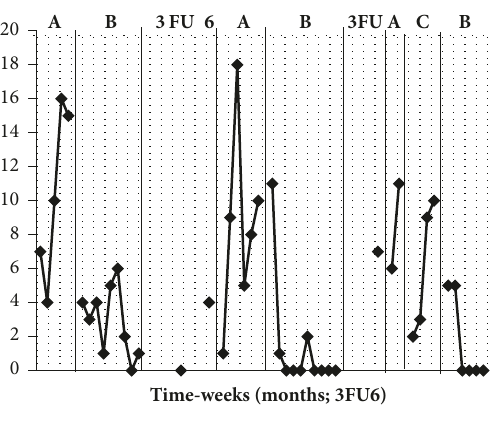
Figure 1: Frequency of voices (y-axis = total number of episodes per week; x-axis = weekly sessions with periods of follow-up (FU) measured at 3 and 6 months after each B phase. Note: A = baseline, B = ATT, and C = autogenics).